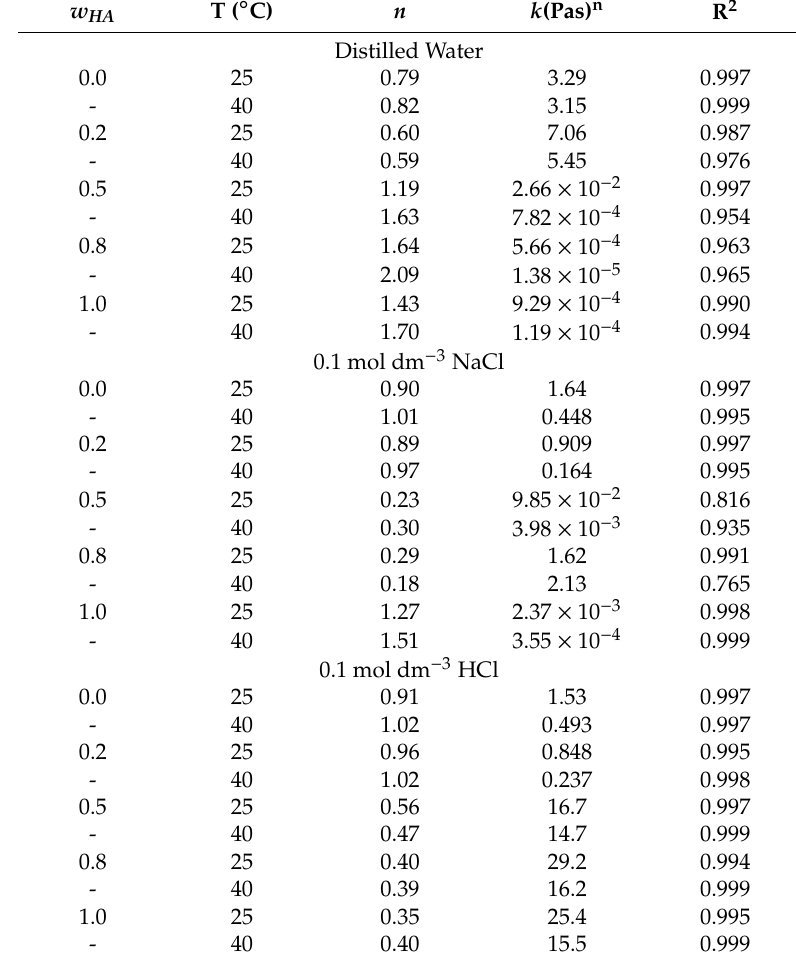
Table 2. The rheological parameters from power law model for HA, PVA and their blends as functions of temperature. w HA T ( ◦ C) n k (Pas)